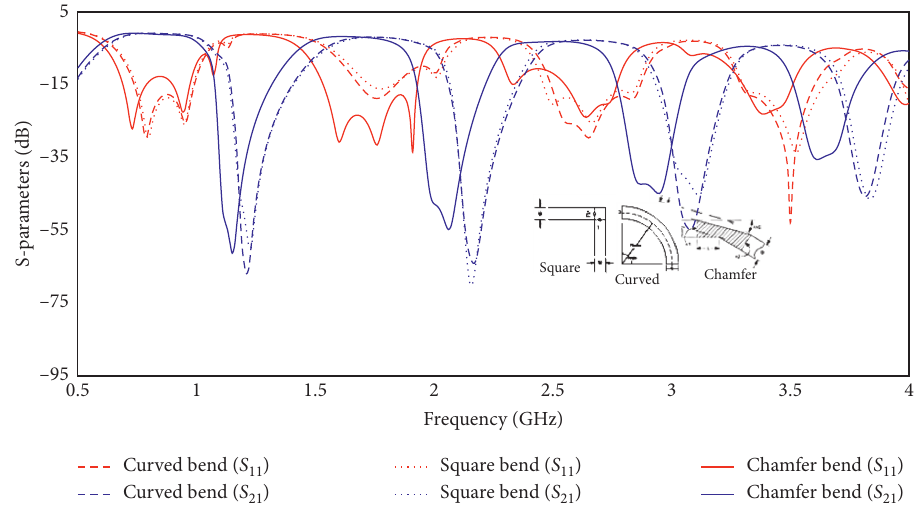
Figure 11: The transmission coefficients ( S 21 ) and reflection coefficients ( S 11 ) of the proposed MW-BPF using an FQC-SSIR with a varied bend/corner